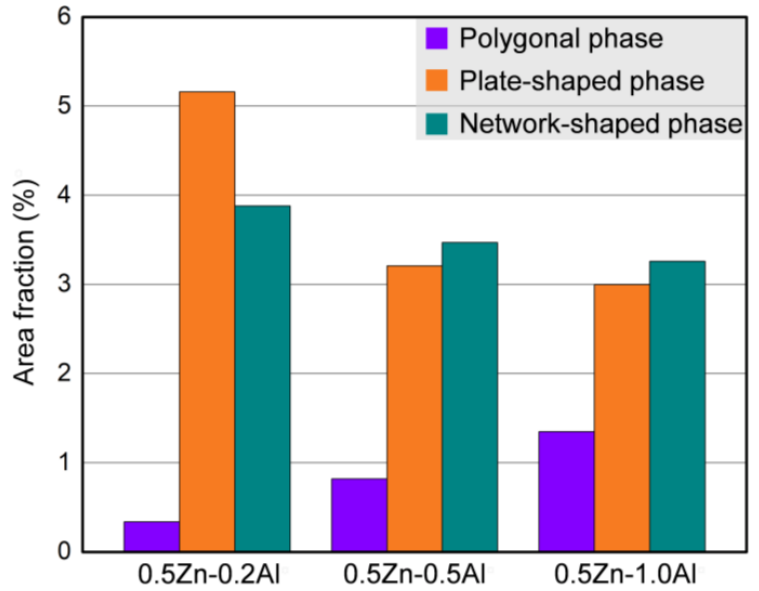
Figure 7. The area fractions of secondary phases in as-cast alloys. electronic diffraction (SAED) patterns of the secondary phases in the as-cast 0.5Zn-0.5Al alloy. It shows that the particles formed at the grain boundary were comprised of the network-shaped phase (point A) and the plate-like phase (point B) (Figure 8a). Based on the corresponding SAED patterns (Figure 8b,c), these phases are identified as Mg 3 RE (face-centered cubic structure, a = 0.740 nm) and 14H LPSO phases (an ordered hexagonal structure, a = 1.112 nm, c = 3.647 nm) [26,27], respectively. Besides, the polygonal phase (point C) and lamellar structure (point D) (Figure 8d) formed in the grain interior are confirmed as Al 2 RE phase (face-centered cubic structure, a = 0.788 nm) and stacking faults (SFs) [28,29], respectively (Figure 8e,f).